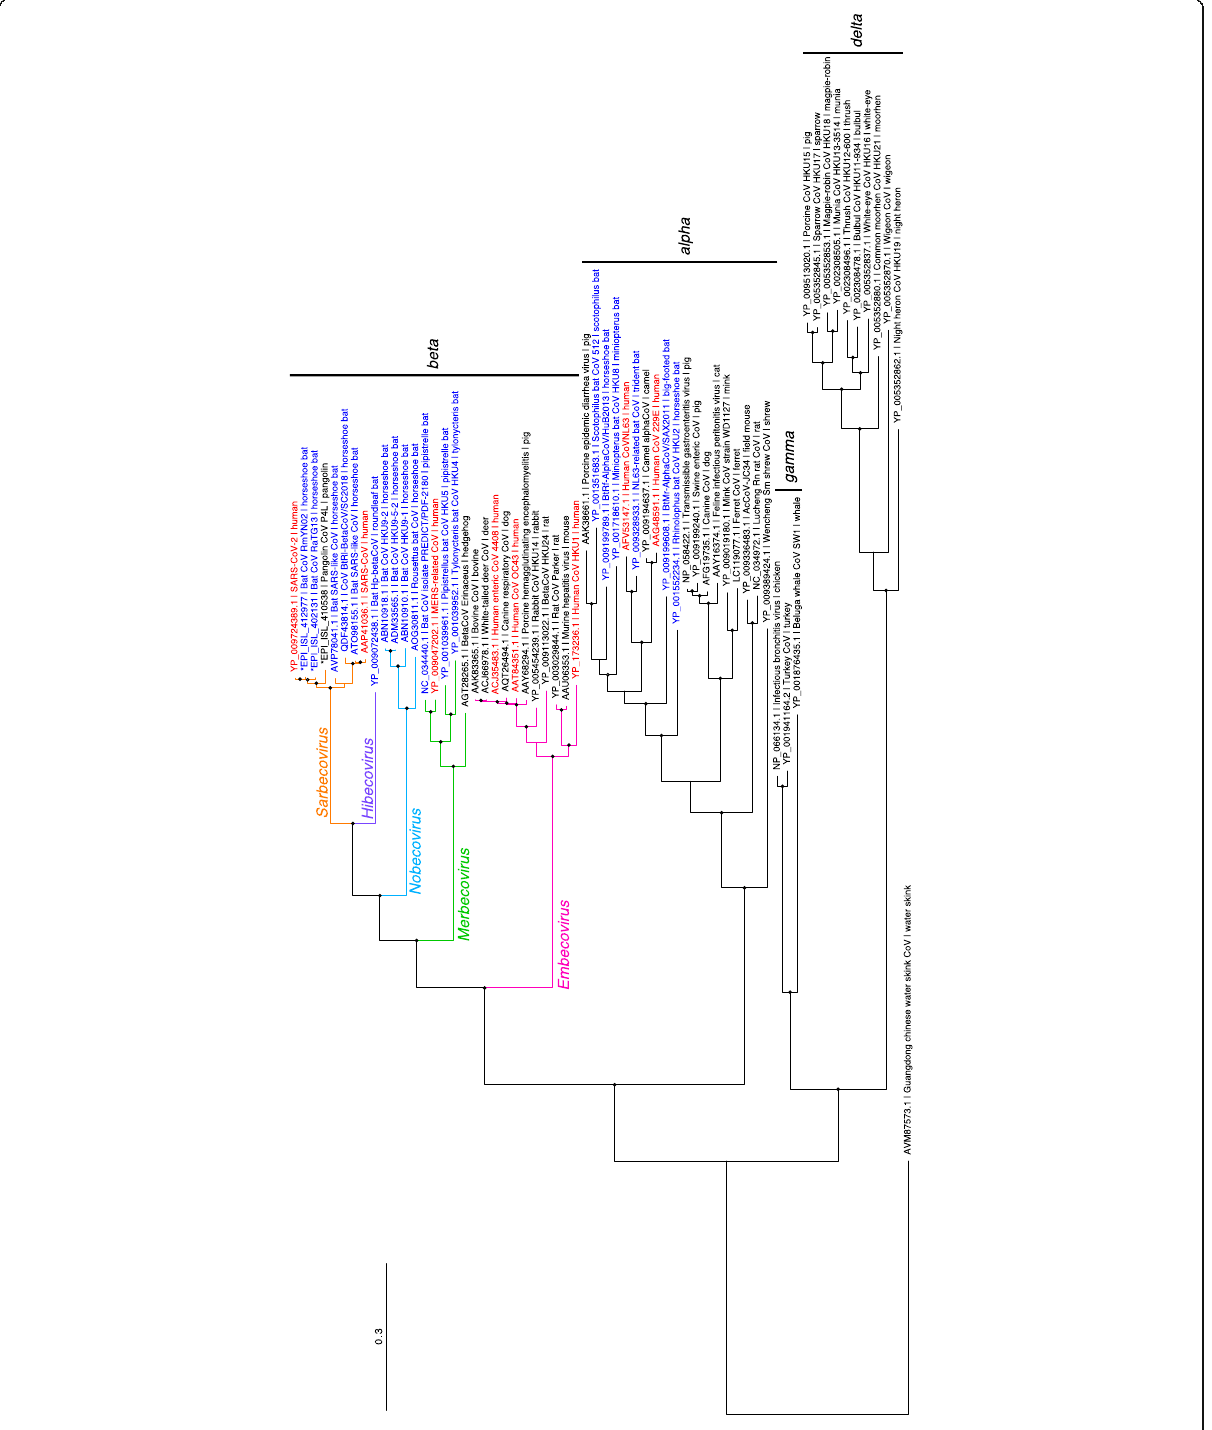
Fig. 1 Phylogeny of orthocoronaviruses. Maximum likelihood (ML)-based phylogenetic tree of 61 orthocoronaviruses. Partial amino acid sequences of ORF1ab were used for the analysis. We generated the multiple alignment of the sequences using L-INS-i of MAFFT version 7.453 [9], and the amino acid substitution model LG+I+G was selected using ProtTest3 [10]. Based on the model, we constructed an ML tree using RAxML- NG [11] applying 1000 bootstrapping tests. GenBank or GISAID (that was indicated by asterisk (*)) accession number, strain name, and host of each virus are indicated for each branch terminal. CoVs obtained from humans or bats are shown in red or blue, respectively. A black or open circle corresponds to bootstrap values ≥ 95% or ≥ 80%, respectively. The scale is shown in the upper